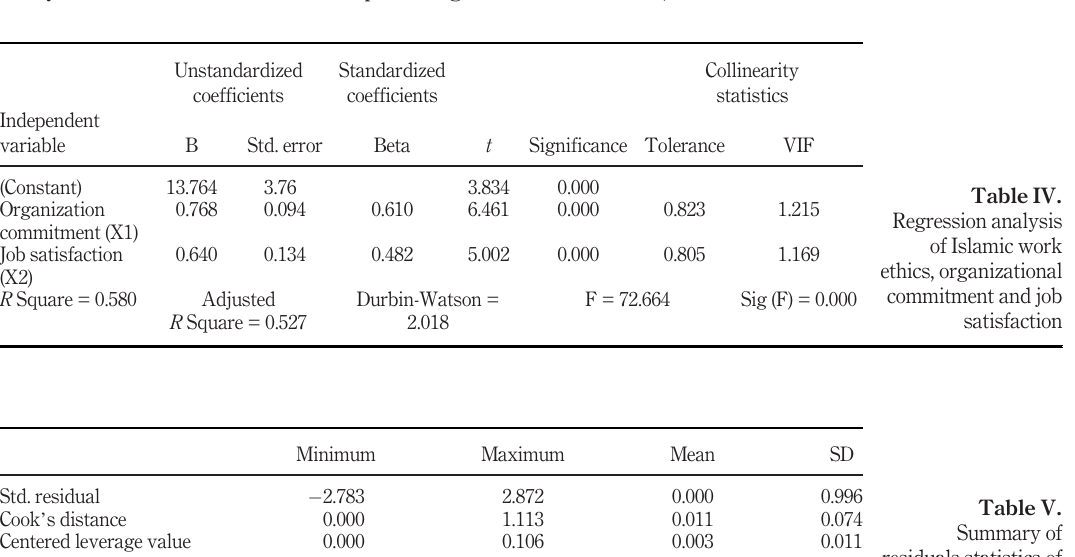
Table V. Summary